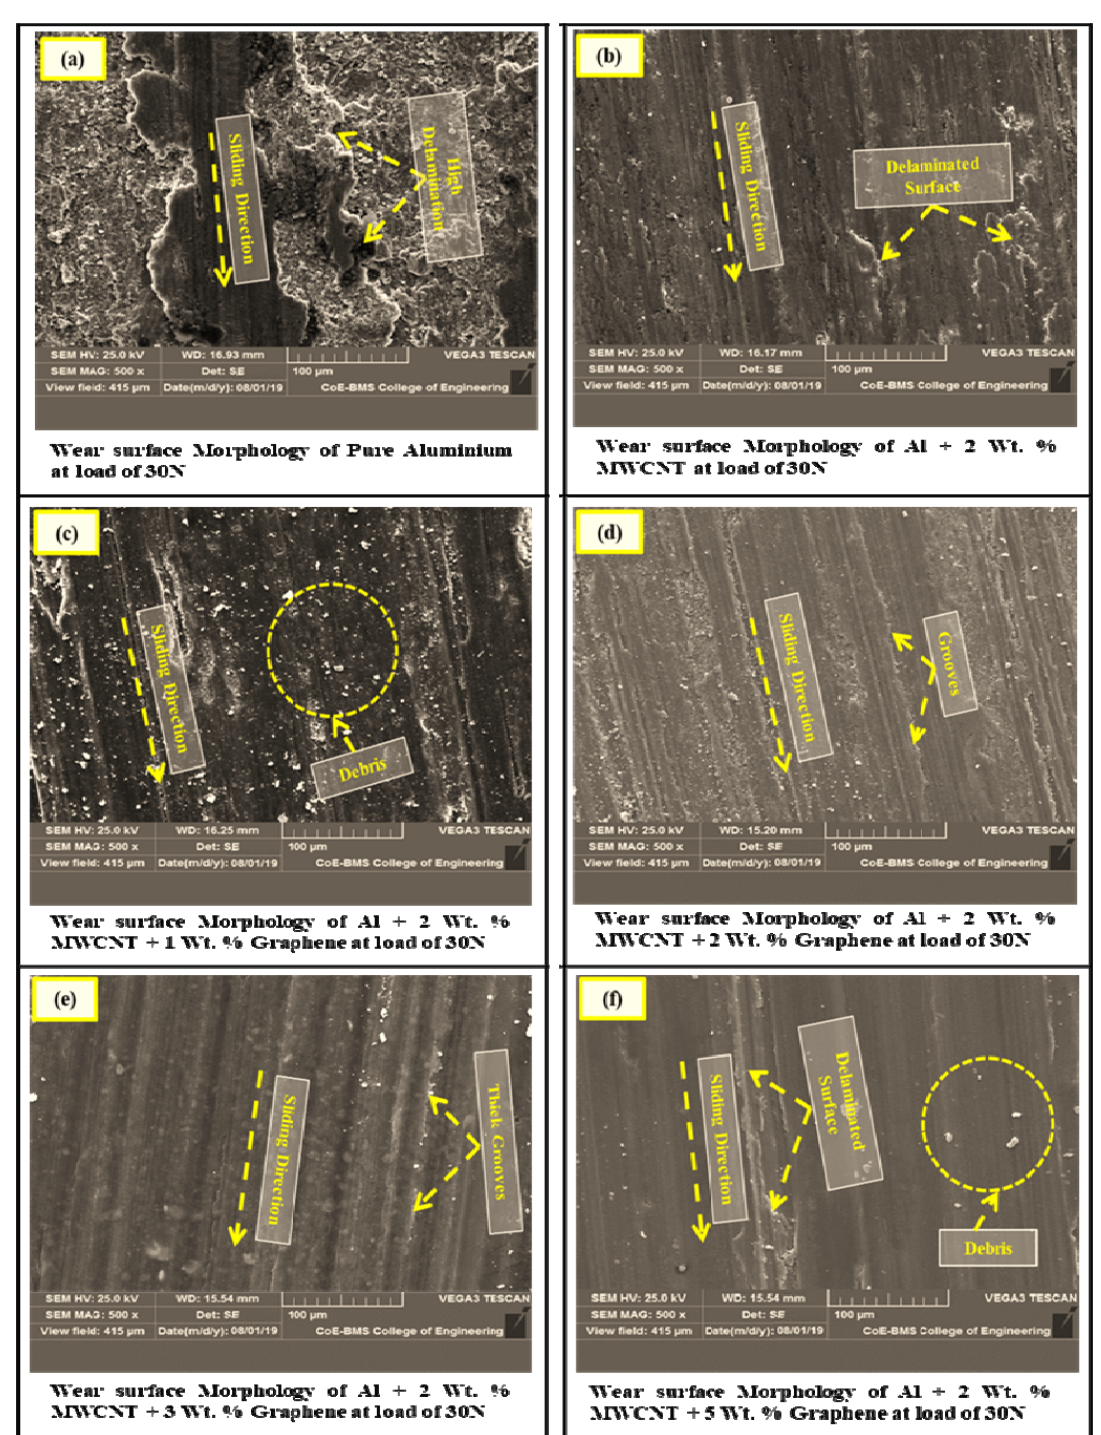
Figure 7. Worn surface of different aluminium and its hybrid composites at sliding velocity of 2 m/s, sliding distance of 1200 m constant and load of